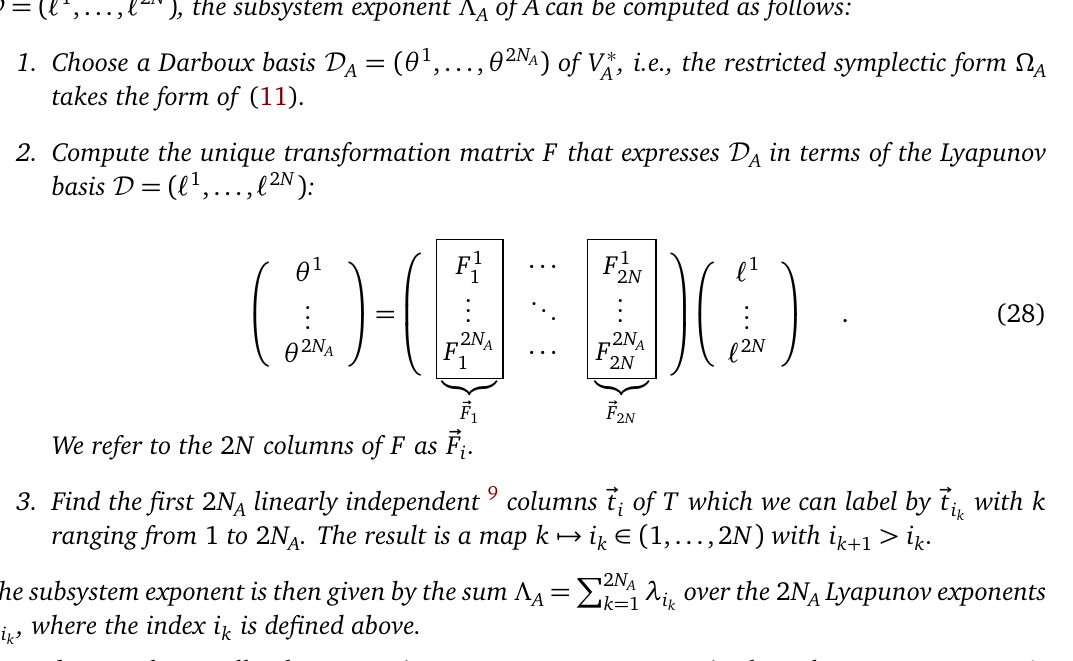
(cid:252) . This figure is